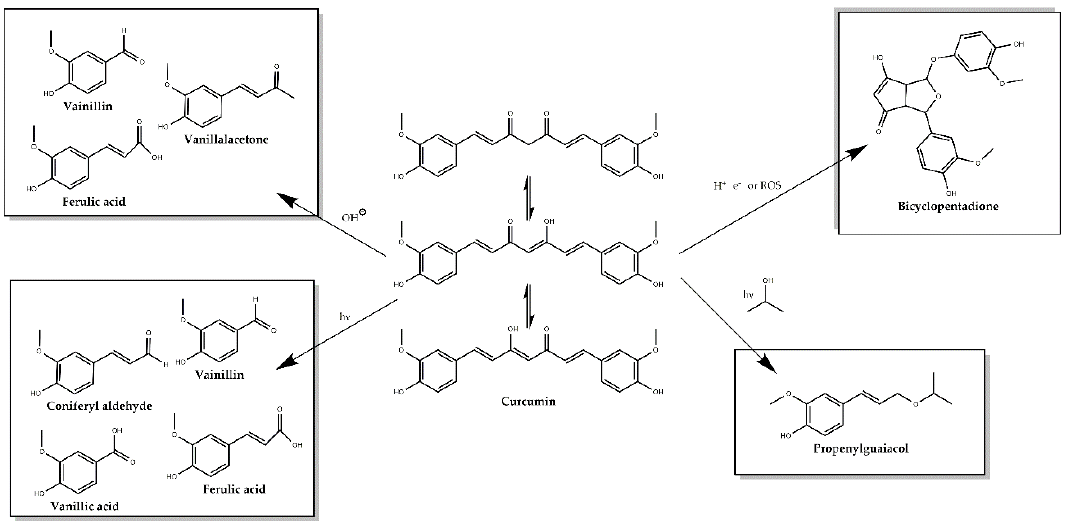
Figure 2. Major degradation products of curcumin under physiological conditions.